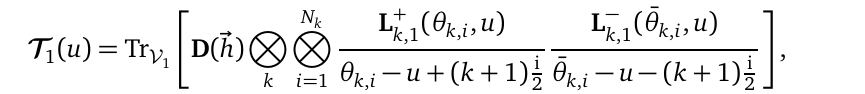
(red) of the k (blue) of the mirror j ∼ = (cid:78) ⊗ 2 N V k . The fundamental column M k k